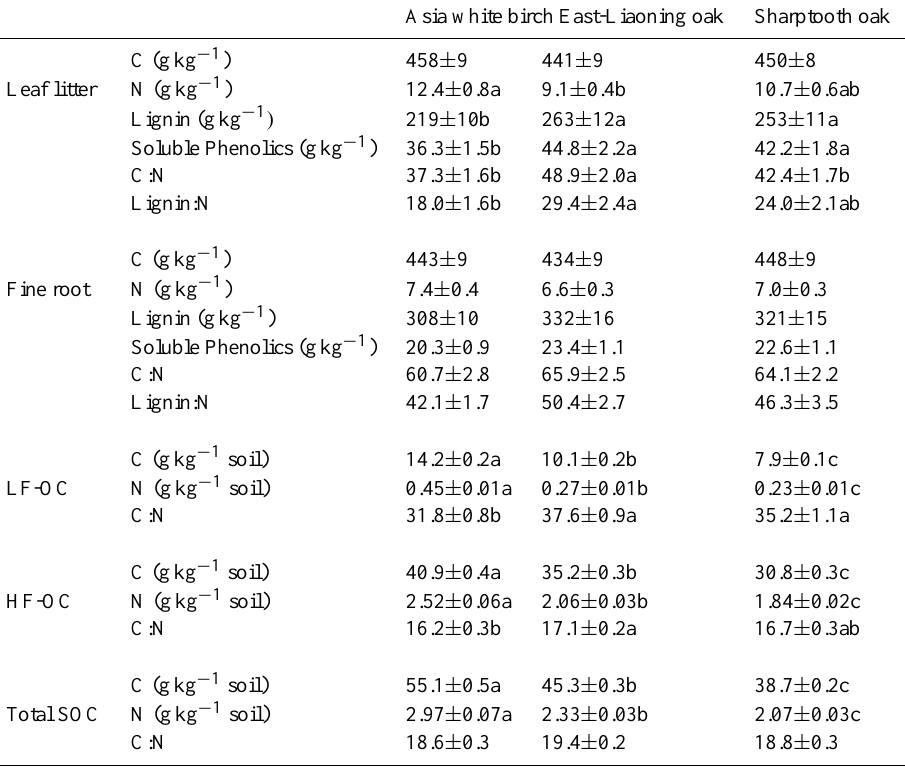
Table 1. Initial chemical content of leaf litter, fine root litter, light fraction organic carbon (LF-OC), heavy fraction organic carbon (HF-OC) and total soil organic carbon (SOC) in the 0–10cm mineral soil layer used in the decomposition experiments in Asia white birch and East- Liaoning oak forests of warm temperate zone and Sharptooth oak forest of sub-topical zone. Values represent mean ± standard error ( n =5). Different letters in each row are significantly different ( P < 0.05) according to the least significant difference